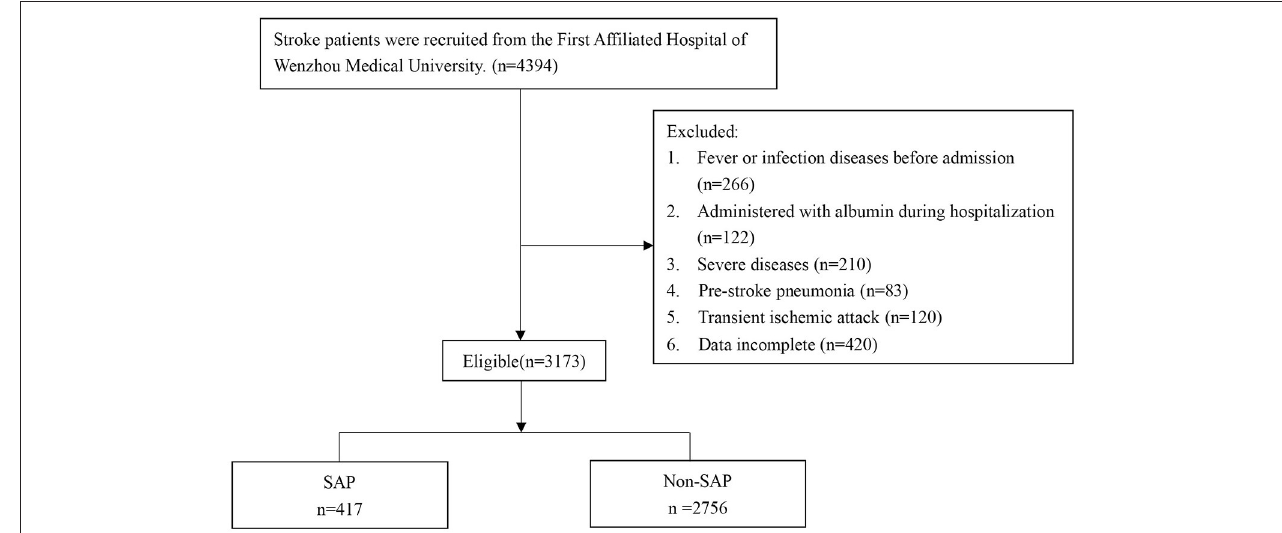
FIGURE 1 | Flow of participants. SAP, stroke-associated pneumonia.